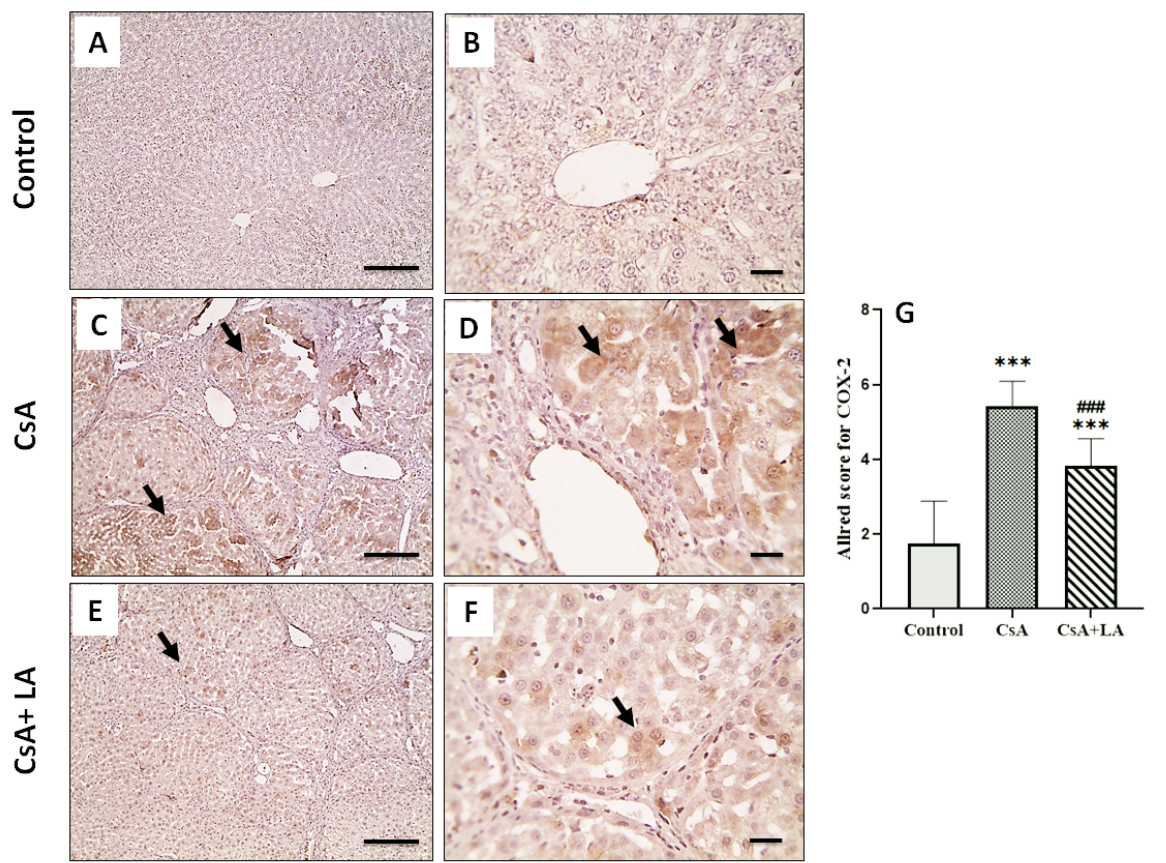
Data are expressed as mean ± SE, * the CsA-treated group versus the control group at p ˂ 0.05, # α - LA + the CsA-treated group versus the CsA-treated group at p ˂ 0.05.